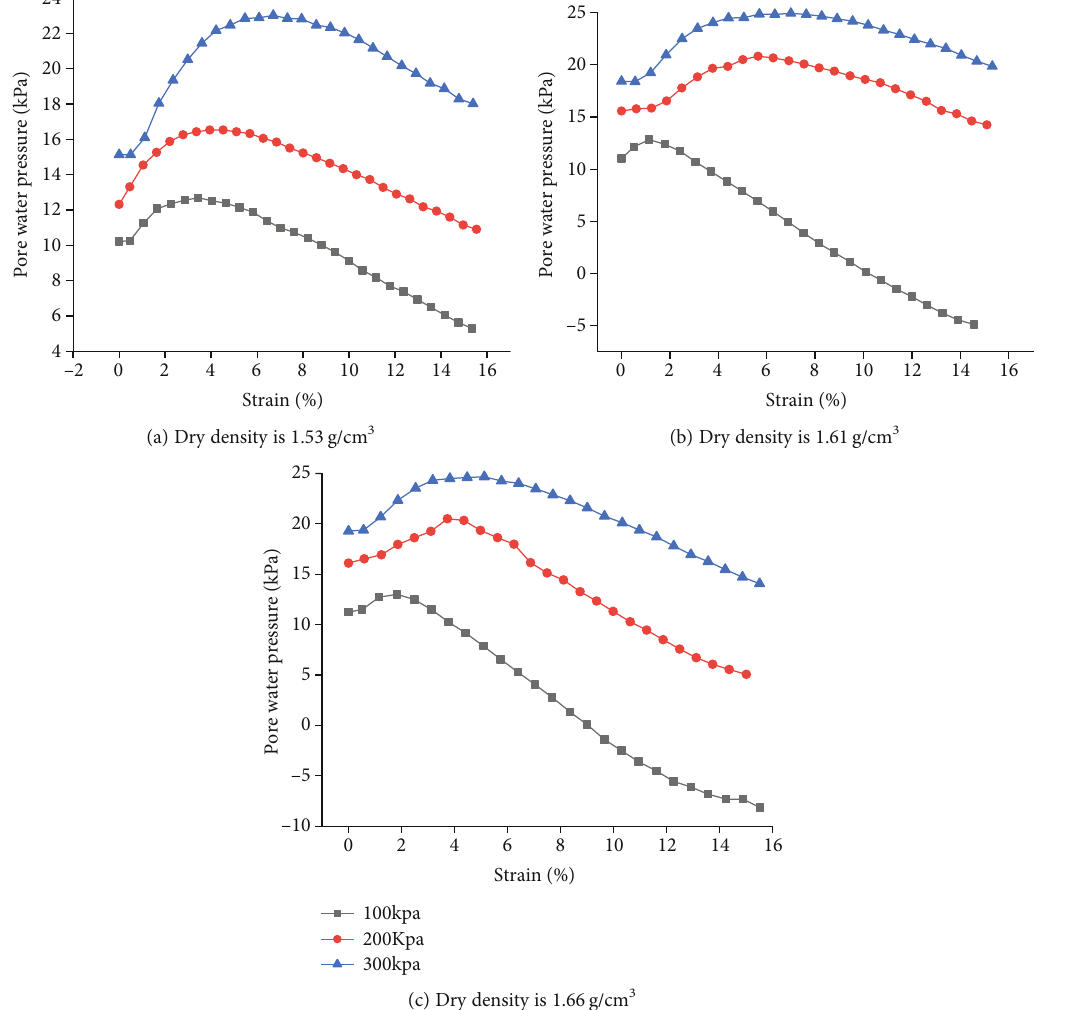
Figure 3: Relationship between pore water pressure and axial strain.